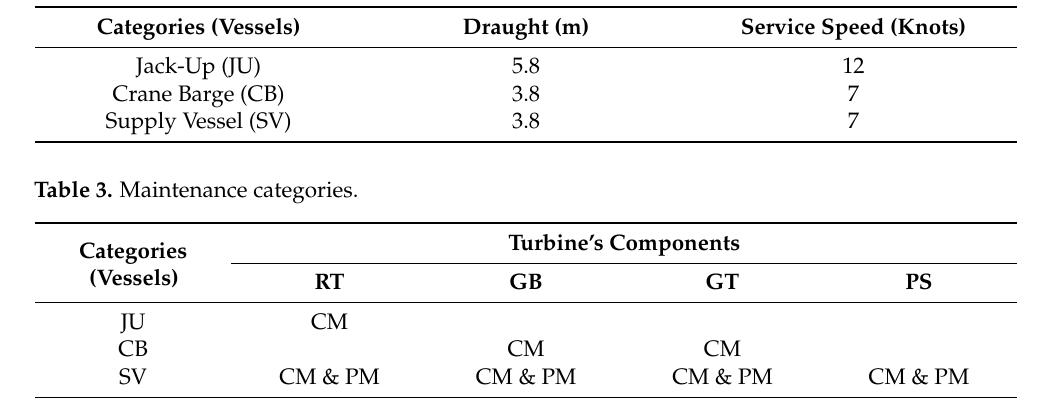
Table 2. Technical specifications of the vessels.